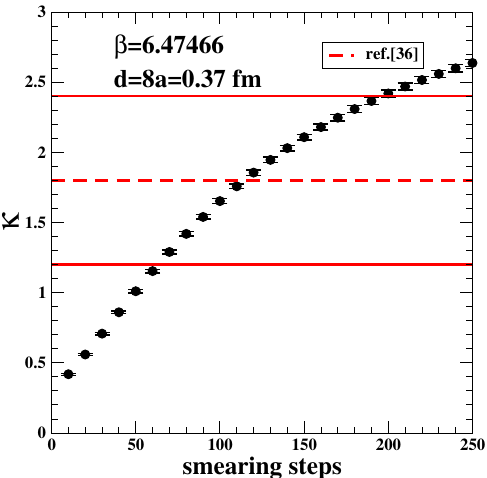
Fig. 11 The Clem κ parameter (full black circles) versus smearing at β = 6 . 47466 and d = 8 a (cid:9) 0 . 37 fm compared to the value obtained in Ref. [36] (the red dashed line is the central value, the red full lines delimit the error